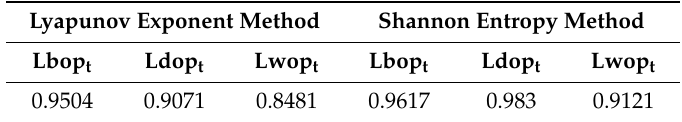
Table 4. Lyapunov exponent and Shannon entropy results 1